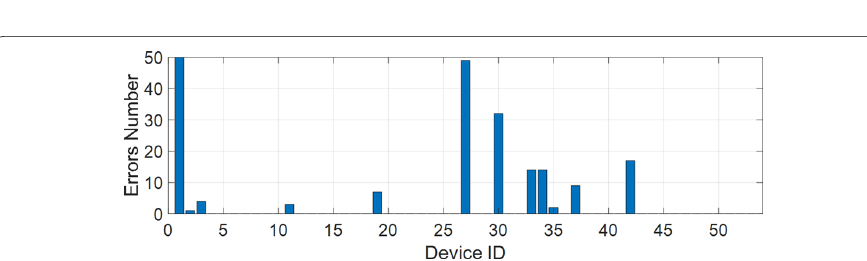
Fig. 21 The number of errors for legitimate devices. The figure shows the number of errors in 50 repeated experiments for each device in